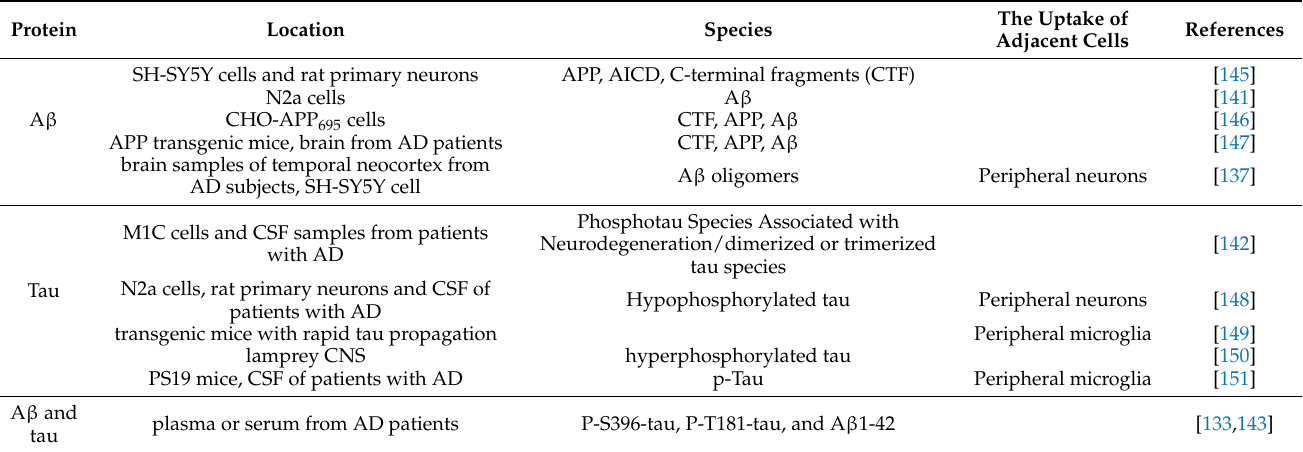
Table 2. AD-associated exosomes contain A β and